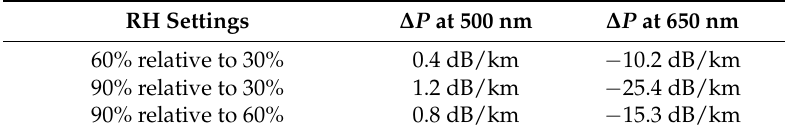
Table 1. Calculated transmission changes from measured OTDR spectra and transmission